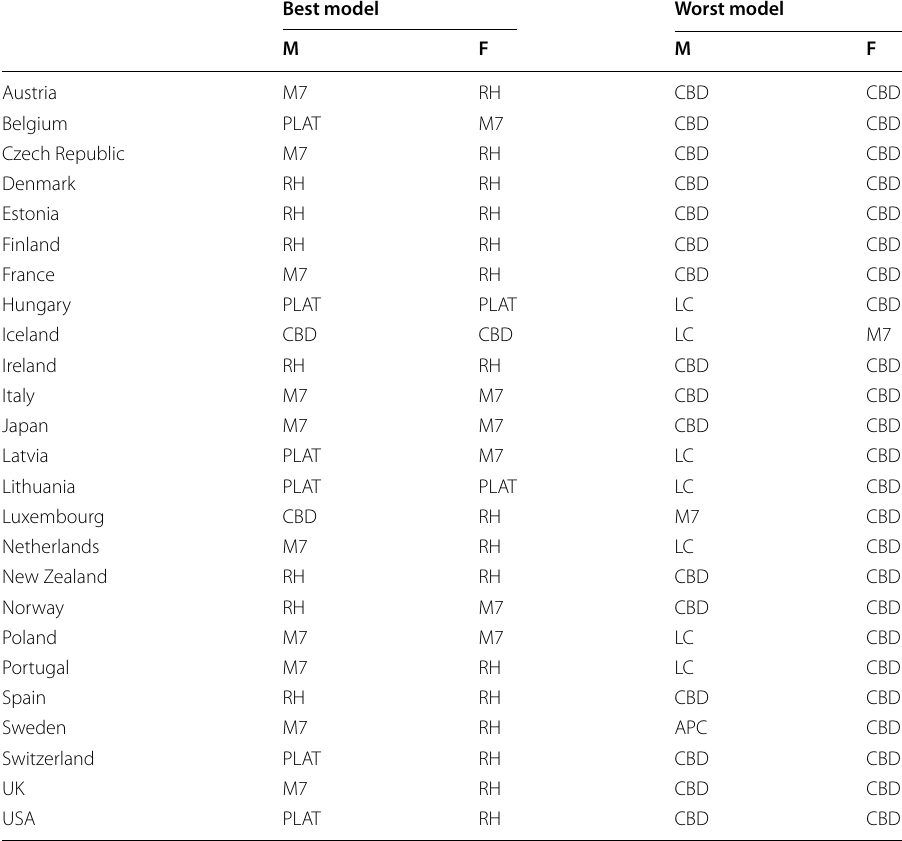
Table 3 Gender-specific best- and worst-fitting GAPC models (countries are listed in alphabetical